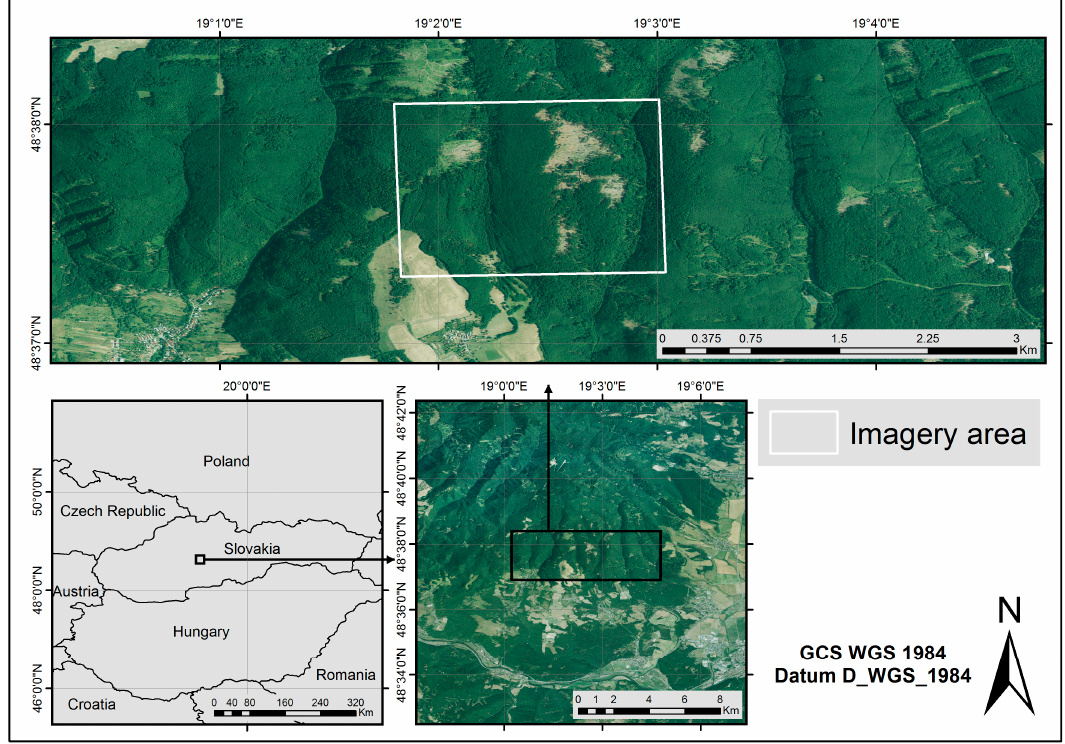
Figure 1. Map of the study site situated in the middle of Slovakia. The white rectangle represents the outlines of the unmanned aircraft systems (UAS)